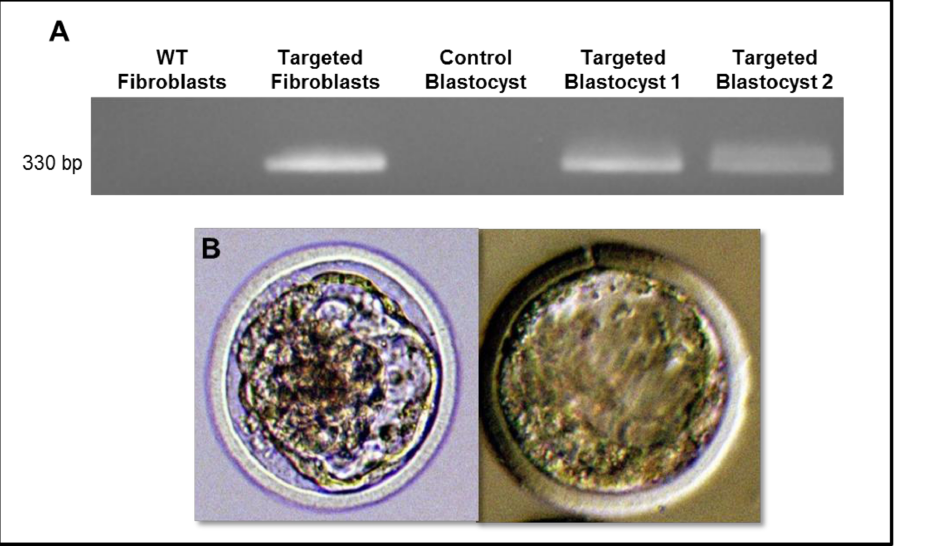
Figure 3. Application of targeted fibroblasts as nuclear donors in SCNT. (A) PCR results demonstrating the presence of the targeted modification in SCNT-generated blastocysts from targeted 3142 fibroblasts. The control blastocyst was generated by SCNT using non-transfected 3142 fibroblasts (WT). One blastocyst was not tested (NT) due to technical issues. (B) Images of the two bovine SCNT-derived blastocysts are shown.